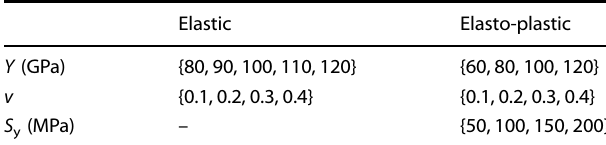
Table 1. Sets of the material properties used for generating the training data.